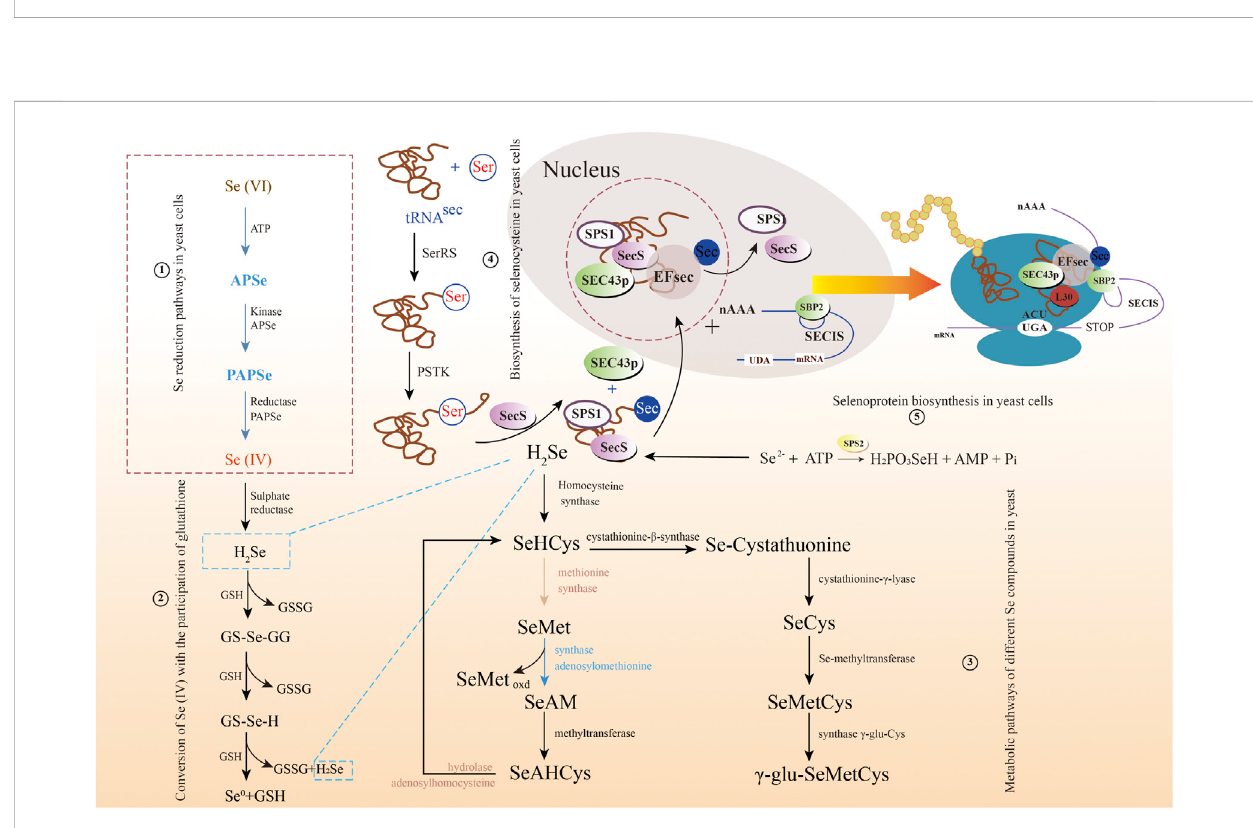
The multiple metabolic pathways of selenate and selenite in yeast. 1) Selenium reduction pathways in yeast cells; 2) Conversion of Se(IV) with the participation of glutathione; 3) Metabolic pathways of different selenium compounds in yeast; 4) Biosynthesis of selenocysteine in yeast cells; and 5) Selenoprotein biosynthesis in yeast